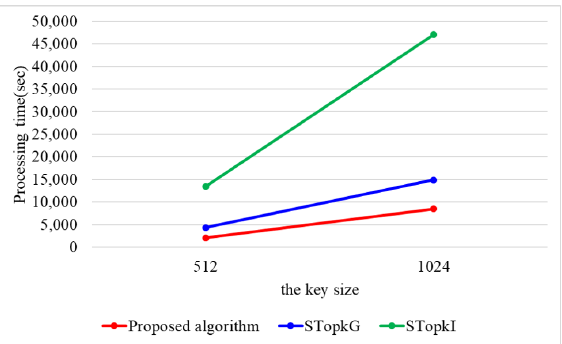
Figure 11. Processing time with a varying key size.